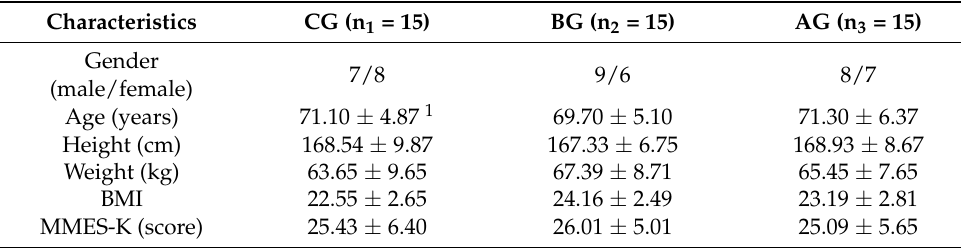
Table 1. Subject characteristics.